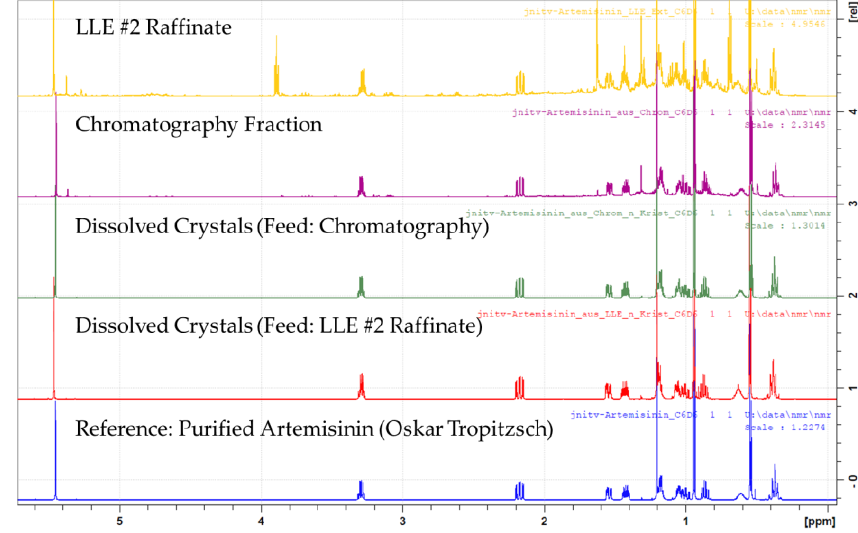
Figure 13. H-NMR measurement of process points. (HNMR: Hydrogen Nuclear magnetic resonance).